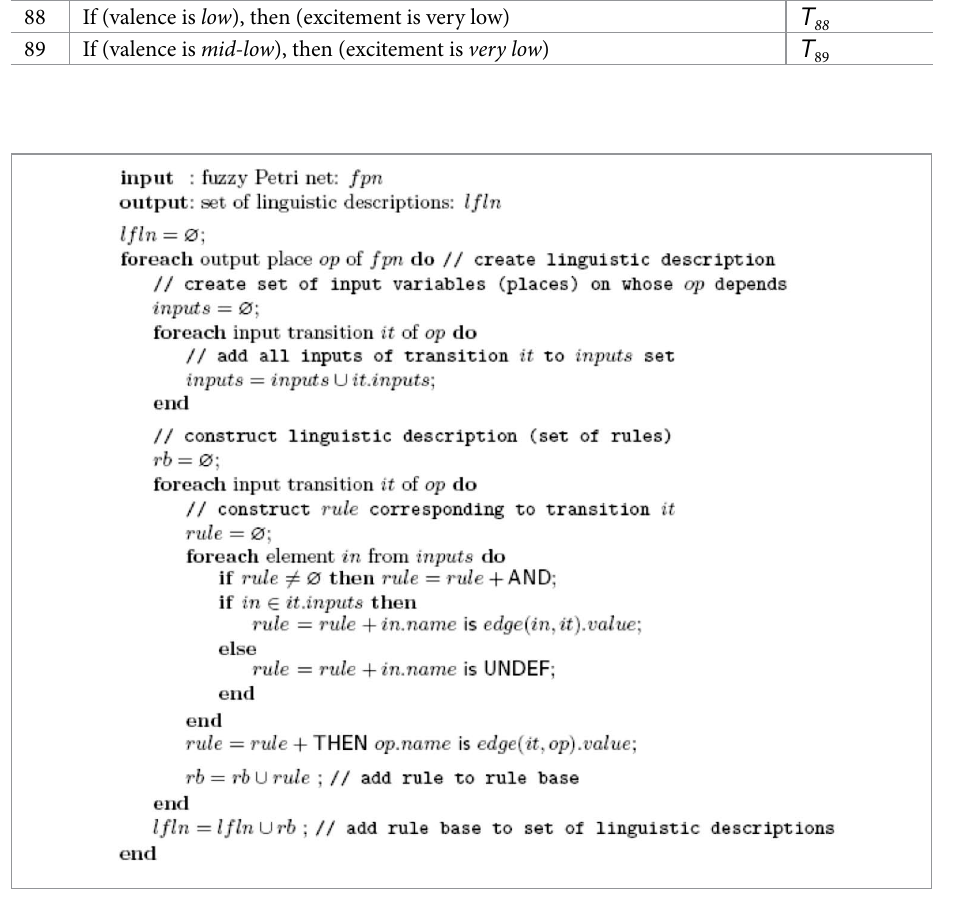
Fig. 7. Reasoning algorithm by (Pavliska 2006) used for the implementation of fuzzy logical Petri nets of this